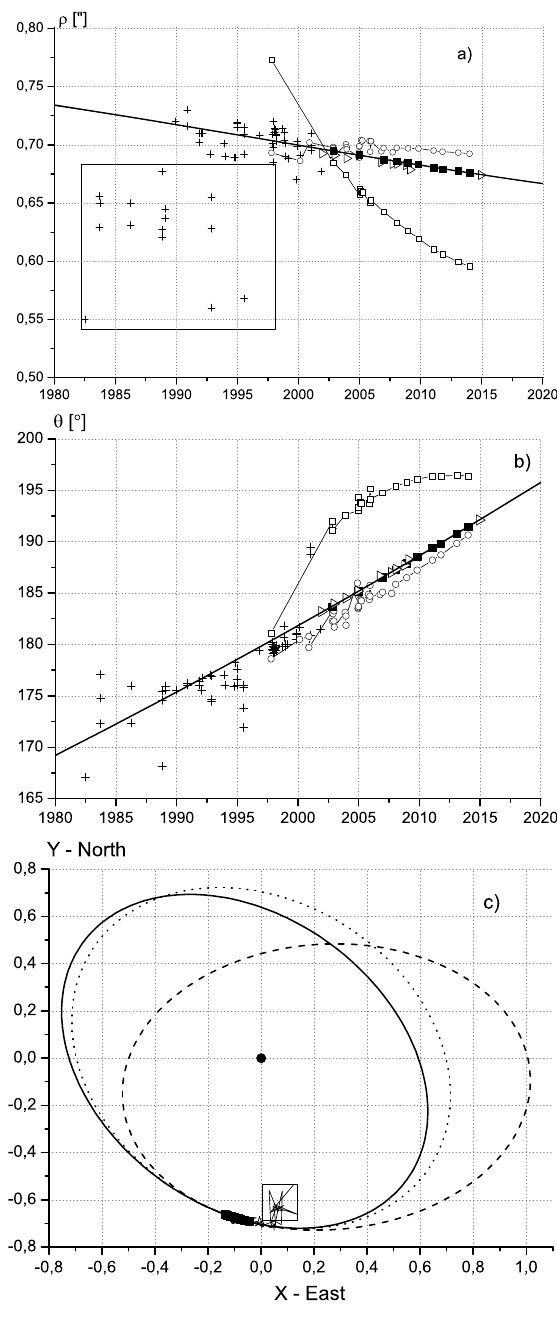
Fig. 6. T Tauri outer (NS) orbits. Comparing with observations: ρ ( t ) (a), θ ( t ) (b), y ( x ) (c). The N-Sa observations are denoted by open circles, the N-Sb observations — by open squares, the photocenter observations — by crosses, the excluded observations are selected in the square; the observations of the SaSb center mass relative to the N component are denoted by black squares (KeckII) and by open triangles (VLT). Lines are ephemeris of the orbits under condition ΣM = 6.1 M ⊙ : the orbit fits e=0.10 (solid line); the orbit fits e=0.39 (dash line), the circle orbit (dot line). On Figs. 6a) and 6b) all lines